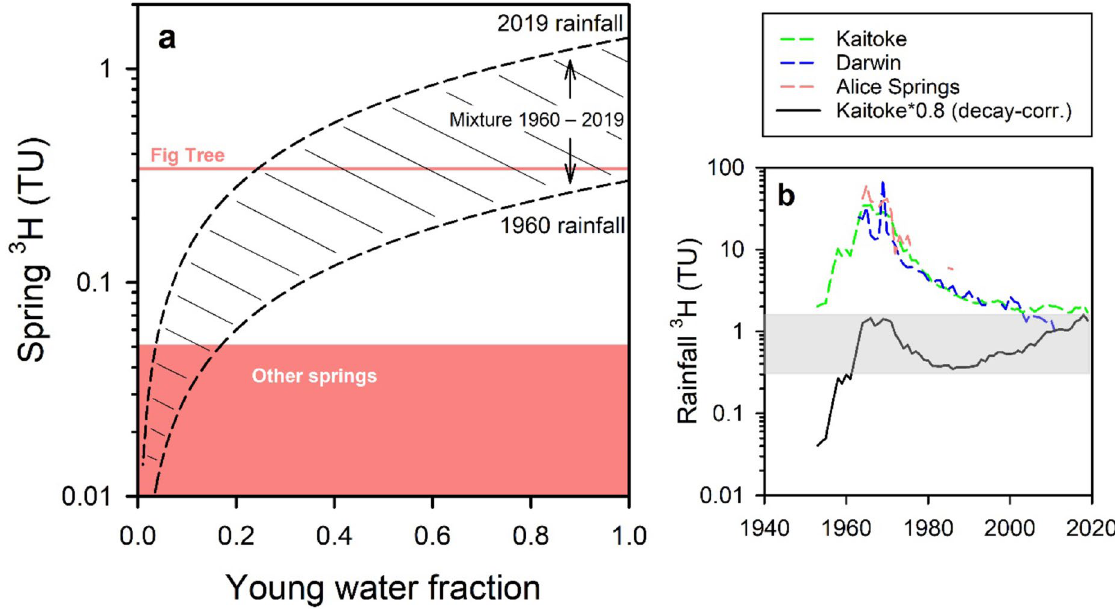
Figure 7. (a) Estimation of the ‘young’ groundwater component in the springs based on (b) the decay- corrected 3 H content for rainfall between 1960 and 2019 (shaded area). As 3 H is near analytical detection limit in springs other than Fig Tree, the young age fraction is an upper estimate for them. The envelope of potential admixtures of young and old water also considers most potential age-distributions within the young